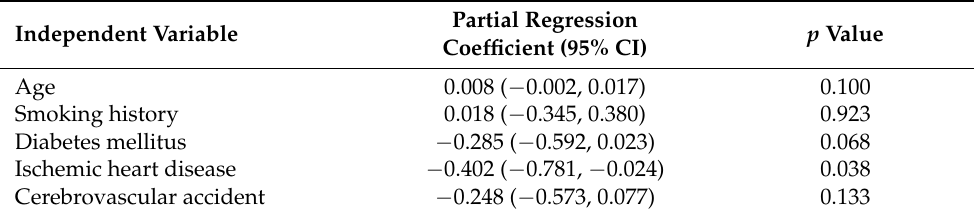
Table 4. Multiple linear regression analysis of the predicted changes in the diameter of the outflow vein from the arteriovenous access after brachial plexus block.